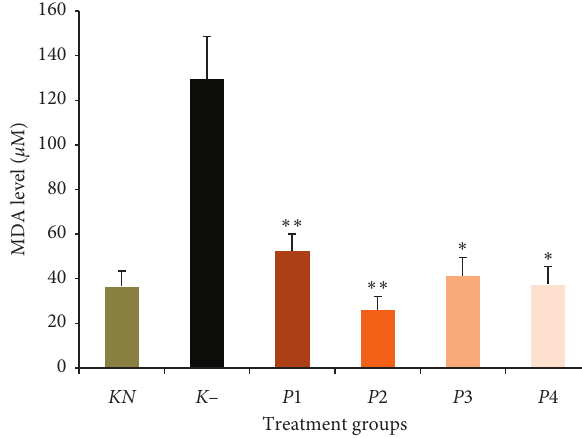
Figure 3: Effect of methanol extract of okra pods on malondial- dehyde (MDA) level in lead acetate-induced mice. Values are as expressed as mean ± standard deviation ( n � 5). ∗ P < 0 . 05 shows significant differences with K − , ∗∗ P < 0 . 05 shows significant dif- ferences in KN and K-, confidence interval 95%. KN : normal control, K − : negative control. P 1, P 2, P 3, and P 4 were treated with 50, 100, 200, and 400mg/kg BW methanol extract of okra pods,